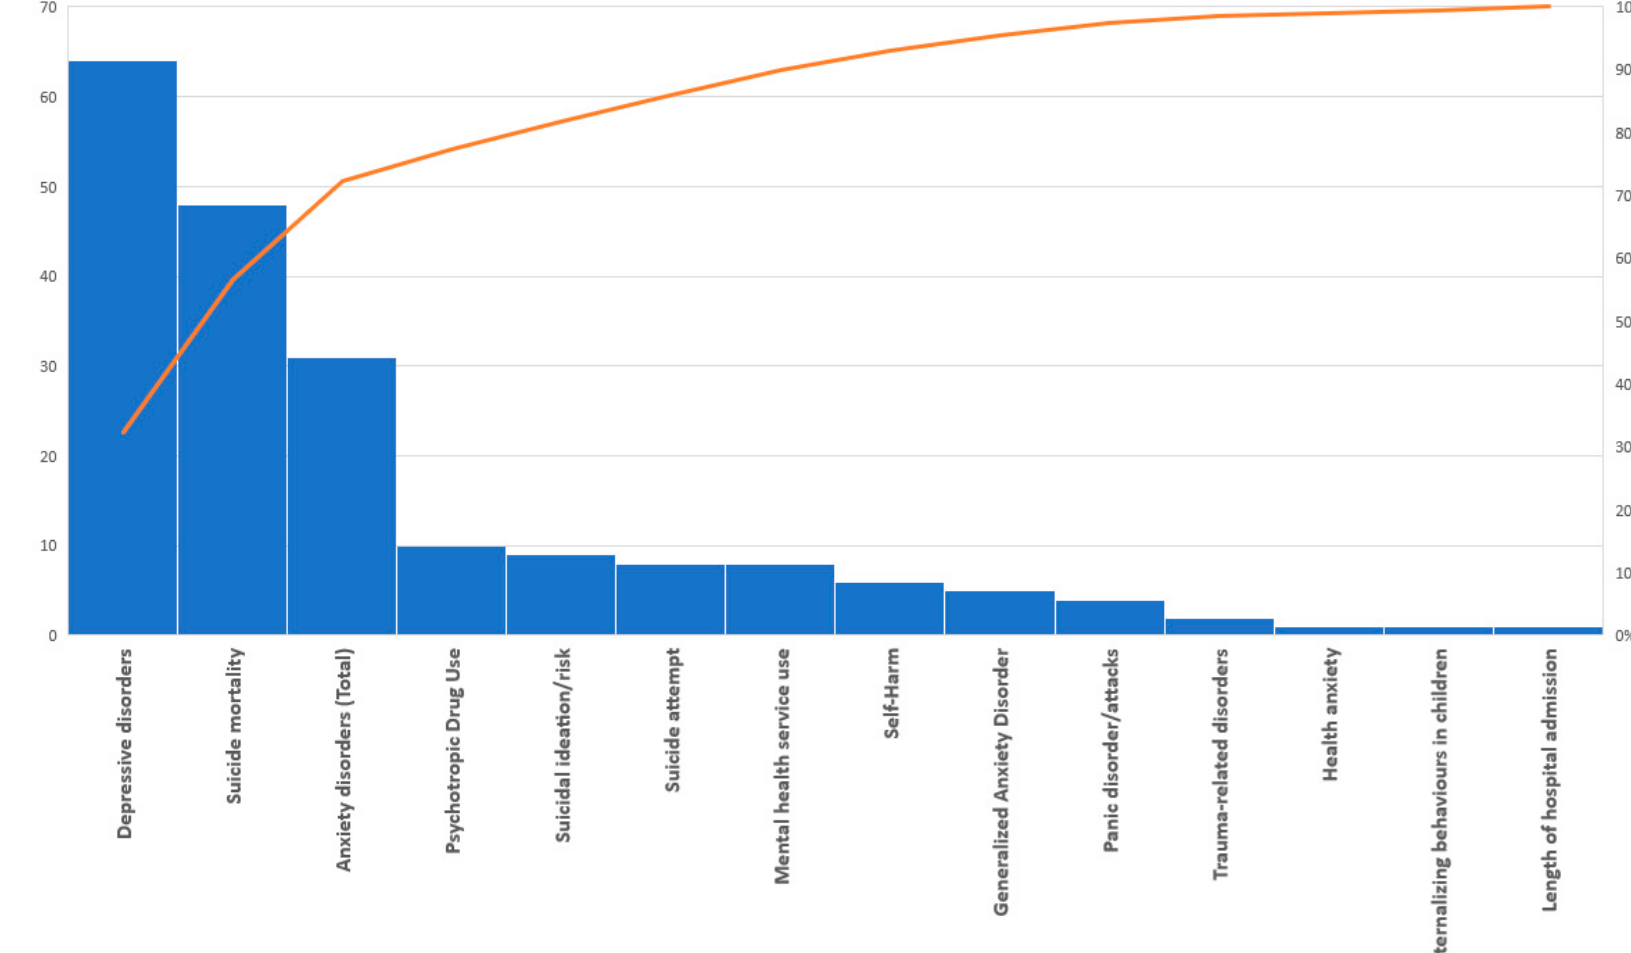
Figure 3. Pareto chart showing the distribution of included papers by outcomes studied.